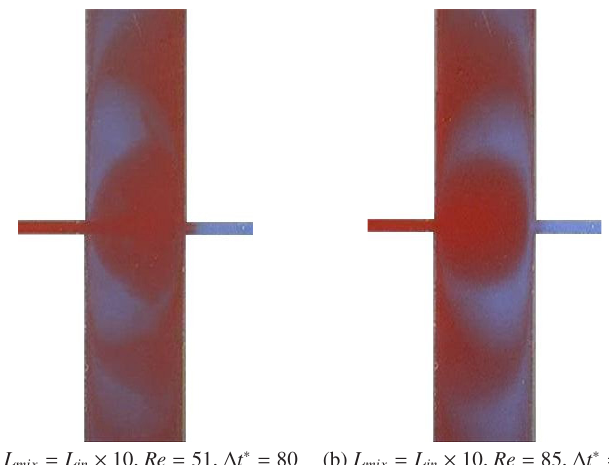
Fig. 8 Asymmetric layered patterns.